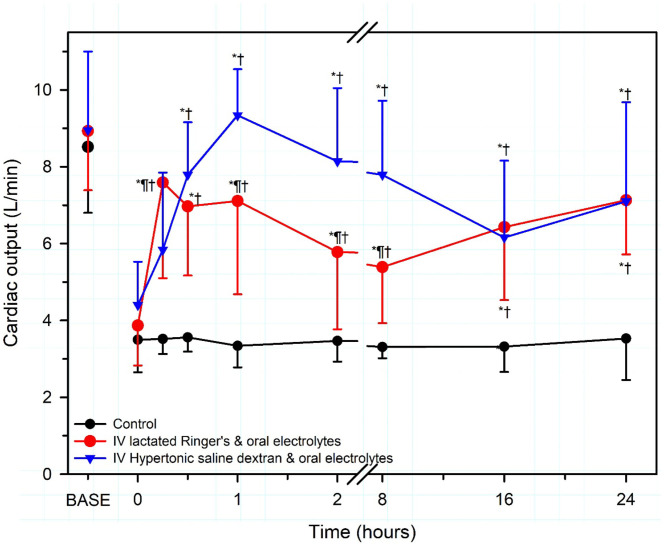
Cardiac output in severely dehydrated diarrheic calves treated with no fluid (Control, black circles; n = 5); intravenous lactated Ringer's solution (80 ml/kg BW for 1 h then 4 ml/kg BW for 7 h) and an oral electrolyte solution (OES; 40 ml/kg BW at 8 and 16 h; red circles, n = 5); or intravenous hypertonic saline-dextran solution (HSD, 2,400 mOsm/L NaCl in 6% dextran-70 at 4 ml/kg BW once over 4 min) combined with an OES (60 ml/kg BW every 8 h for three treatments, blue triangles, n = 5). Base refers to baseline, the time before induction of diarrhea and dehydration. *significantly different from time = 0 h; †significantly different from control group at the same time; ¶significantly different from the lactated Ringer's group at the same time. Revised, with permission, from: Walker et al. (13).